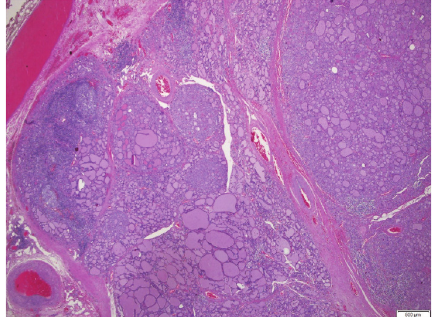
Figure 4: Thyroid gland presenting with lymphocytic thyroiditis and multinodular goiter (H&E, 20x).